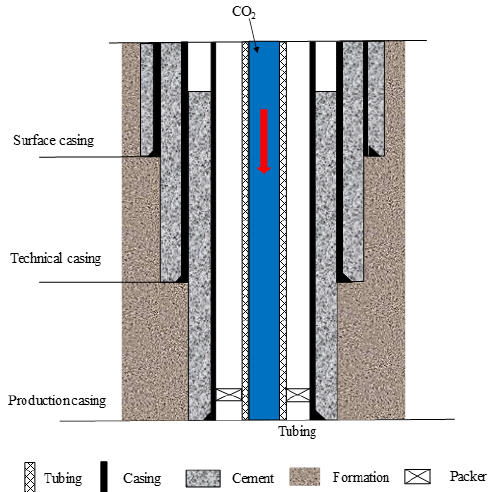
Figure 1. A schematic of a CO2 injection well. Mass conservation The continuity equation derived by mass conservation is shown in Equation (1).